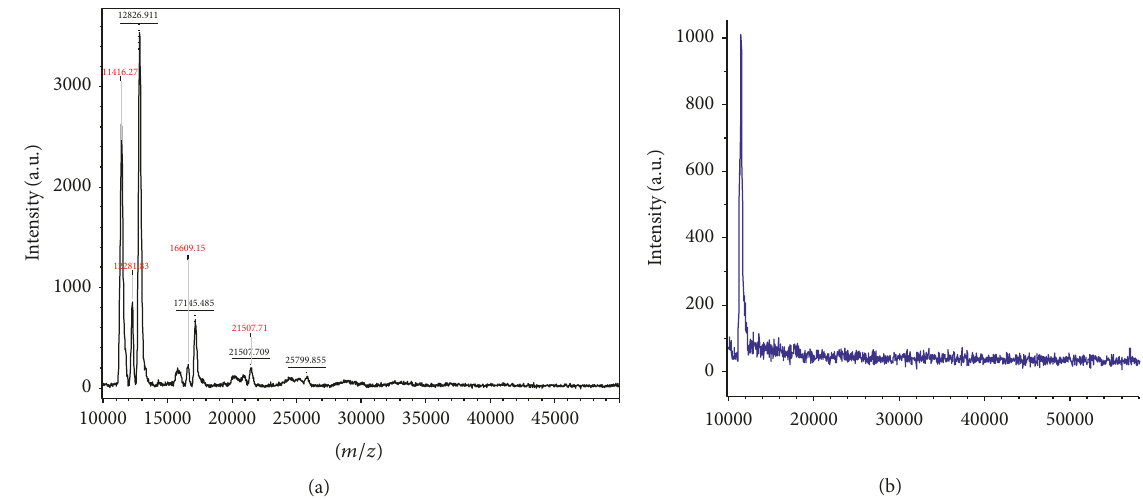
Figure 3: Mass spectrometric display of A 𝛽 42 aggregate size. (a) A 𝛽 42 in PBS (negative control); (b) A 𝛽 42 with 10 𝜇 g/ml OPP. (a) shows the presence of monomers, dimers, trimers, tetramers, and pentames. (b) Shows the presence of only monomers.